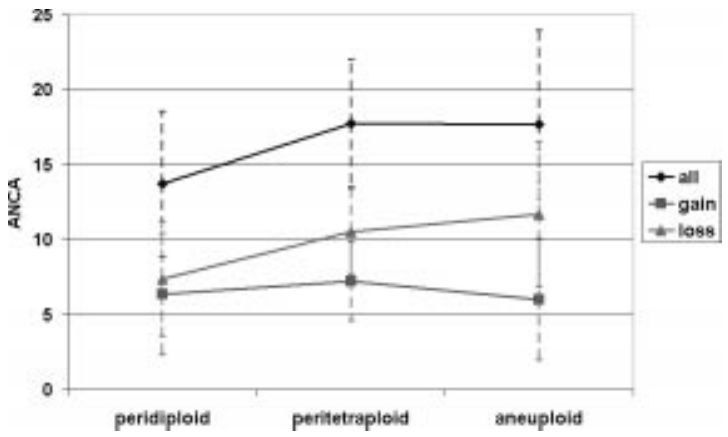
Fig. 1. Averaged number of copy alterations (ANCA). The vertical lines represent the standard deviations.